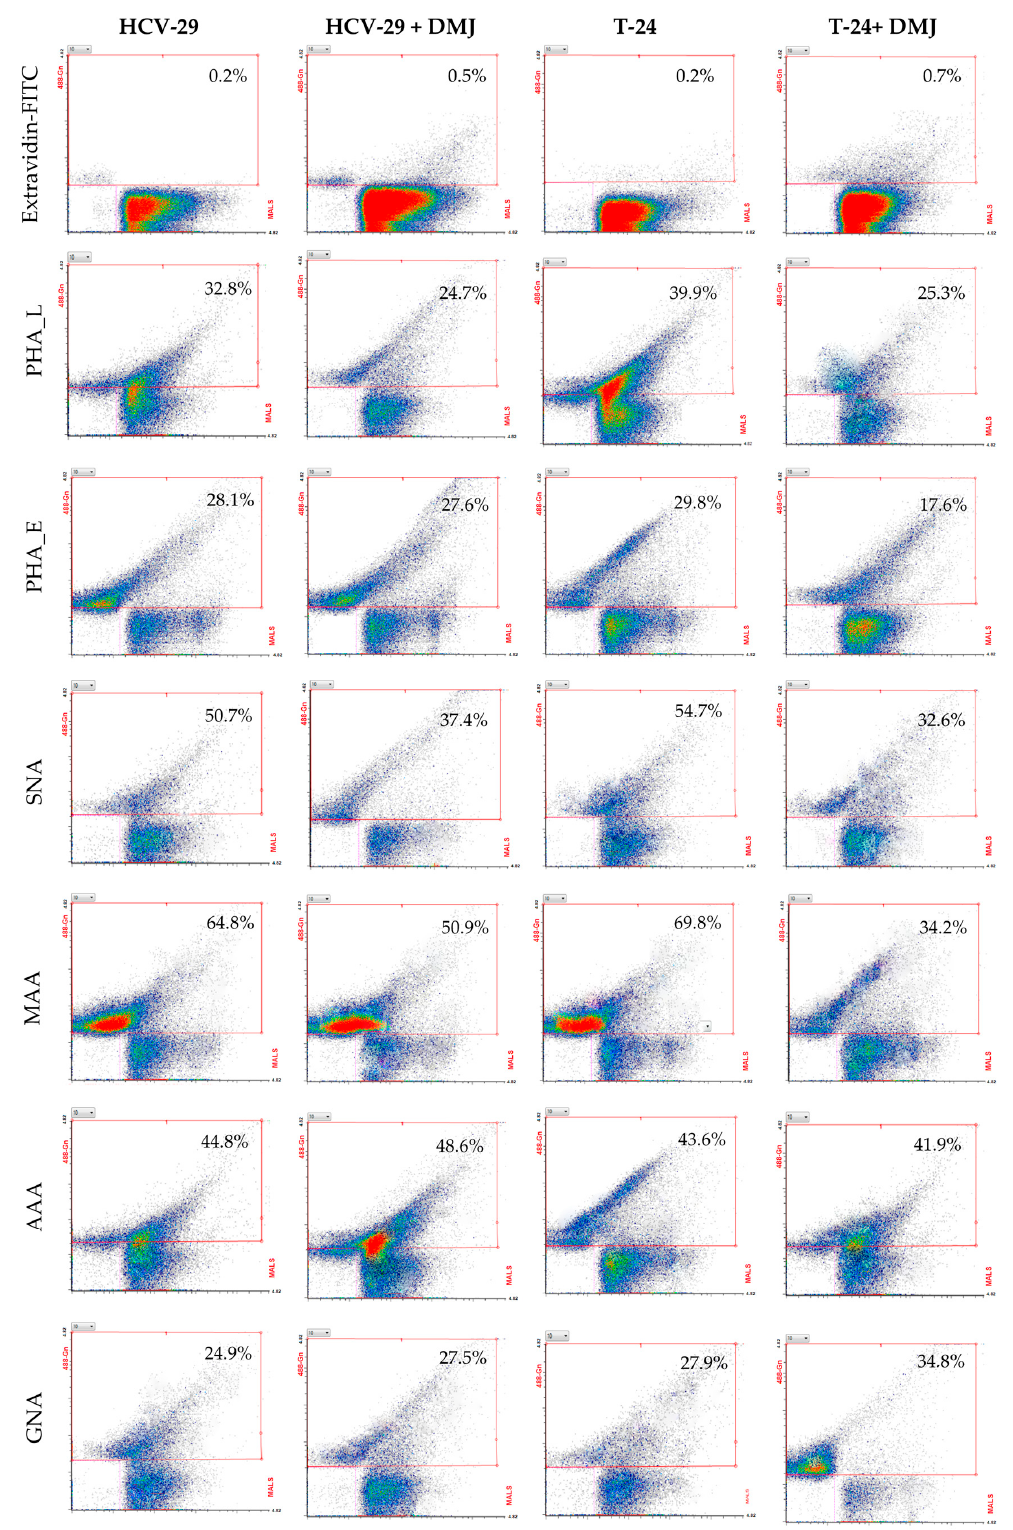
Figure 11. Flow cytometry analysis of surface glycosylation of ectosomes derived from HCV-29 and T-24 cells grown in control conditions or treated with DMJ. Dot plots for MAA-, SNA-, GNA-, AAA-, PHA-E- and PHA-L-positive ectosomes. Results for control secondary extravidin-FITC conjugate staining are also provided. The X axis shows values obtained at medium angle light scatter (MALS), Y axis shows log fluorescence intensity measured on 488Gn